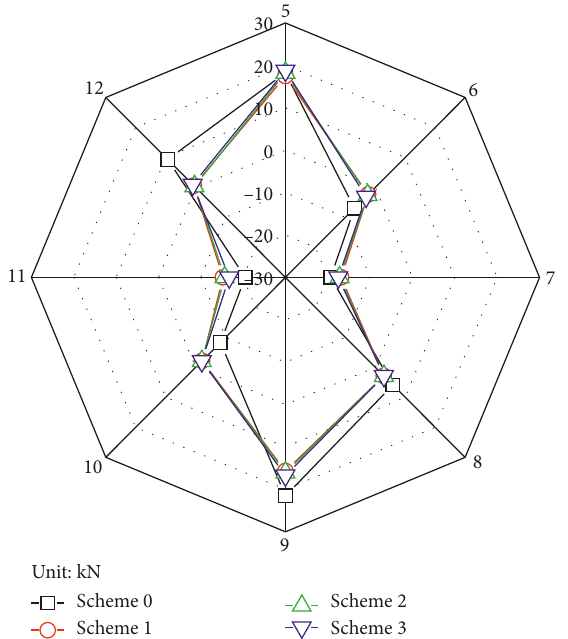
Figure 24: Additional shear forces of the tunnel structure after foundation pit excavation.